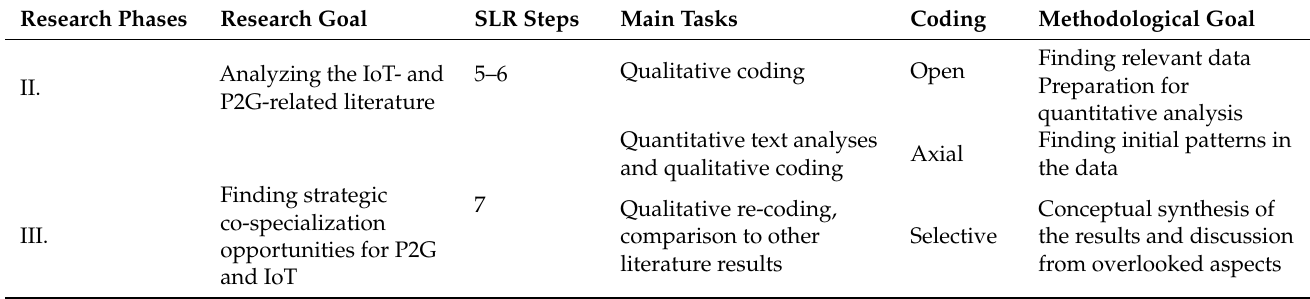
Table 2. Summary of the data collection and analysis process (own construction).